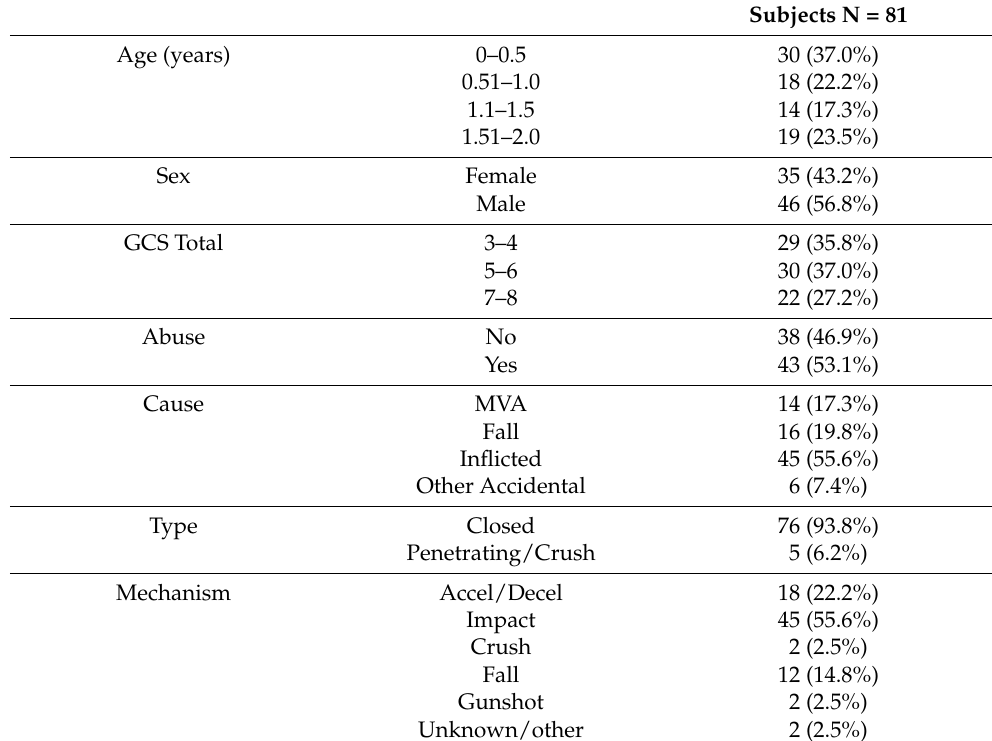
Table 1. Demographics and Injury